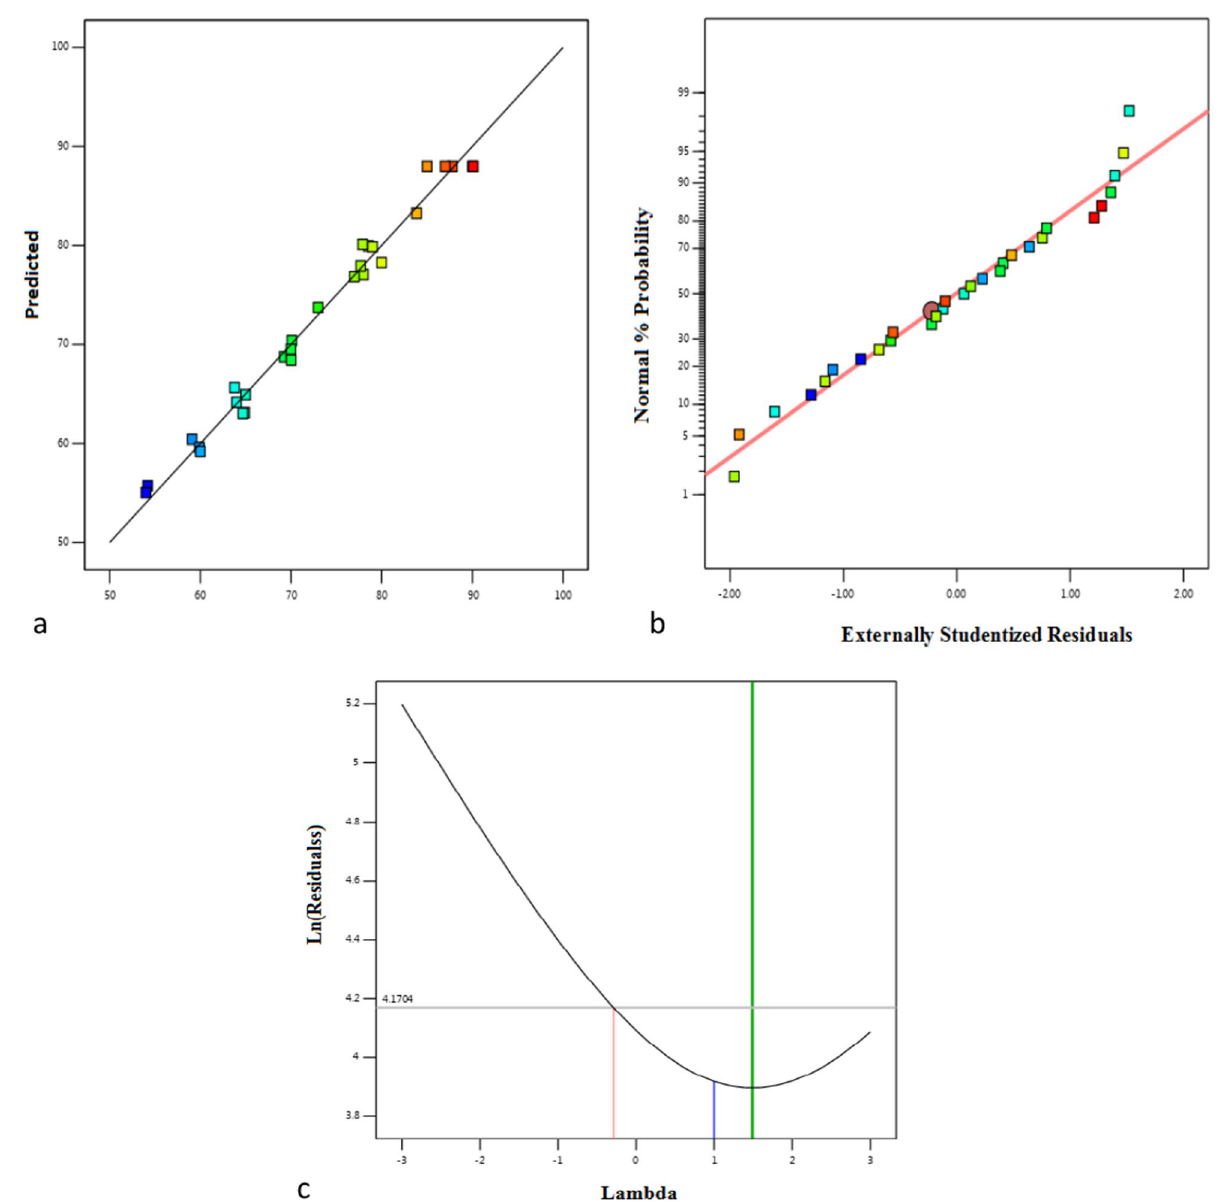
Figure 20. ( a ) The actual and predicted values for the decolourization of MG dye by immobilized Mucor sp., ( b ) normal % probability and ( c ) the Box–Cox